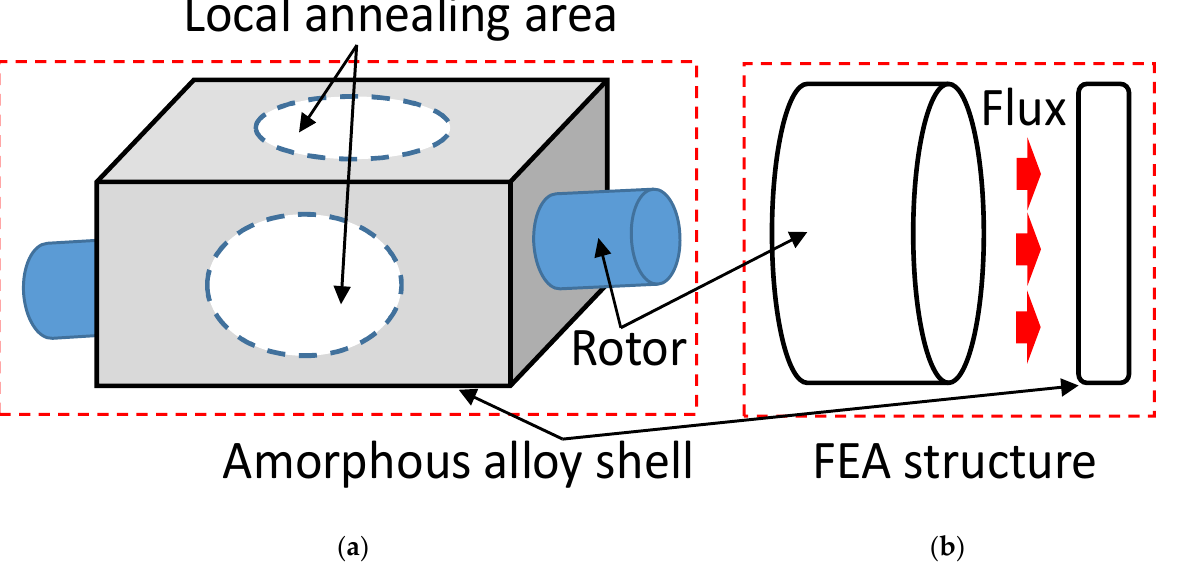
Figure 6. Experiment structure: ( a ) flux path on surface of the amorphous shell and ( b ) coated (uncoated) amorphous alloy of the generator shell.